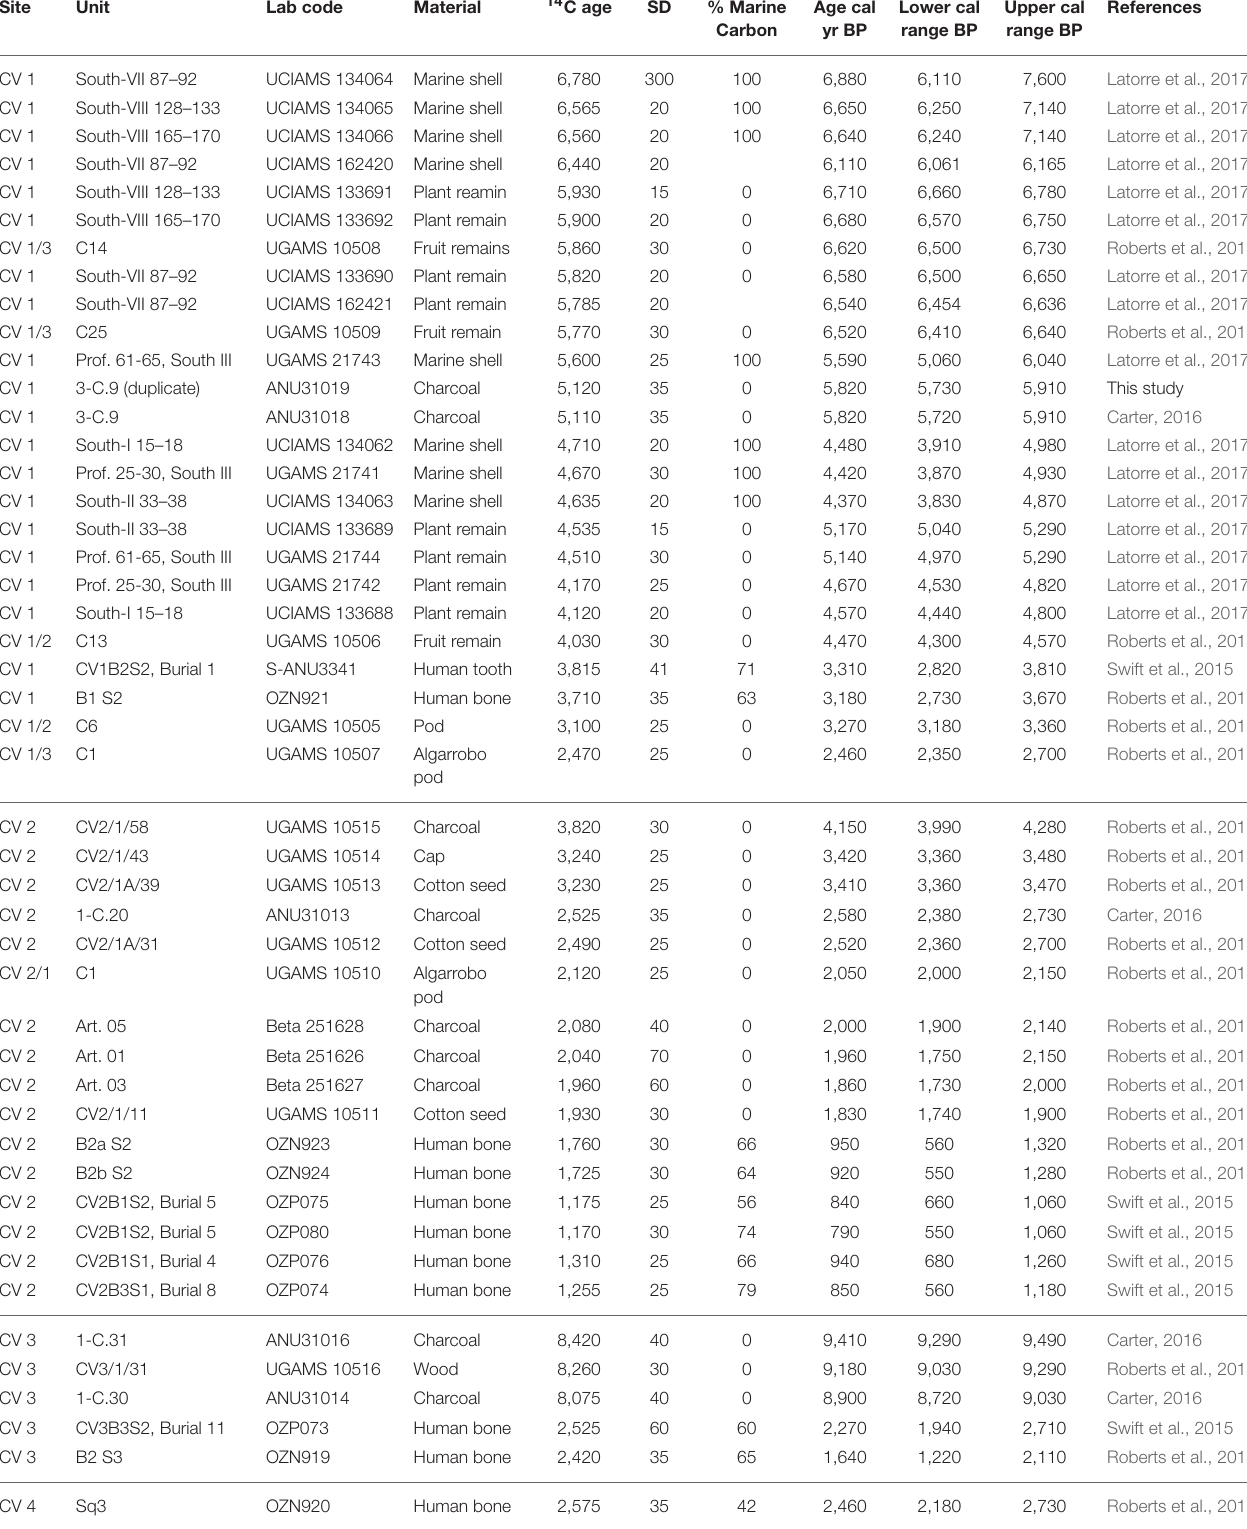
TABLE 2 | Compilation of 70 AMS dates from six archeological areas defined at Caleta Vitor